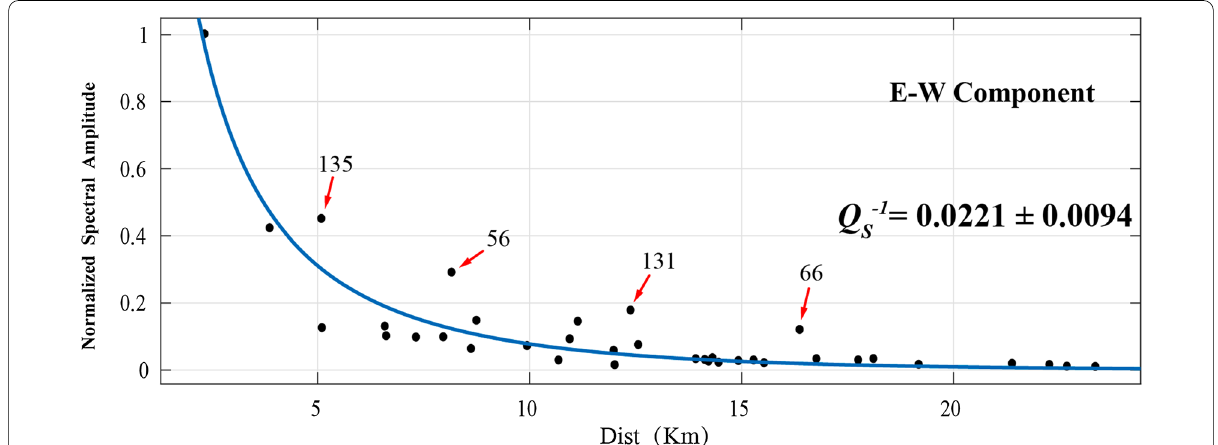
Fig. 10 Normalized spectral amplitude attenuation curve of S waves. The red arrows mark the numbers of the 4 anomalous